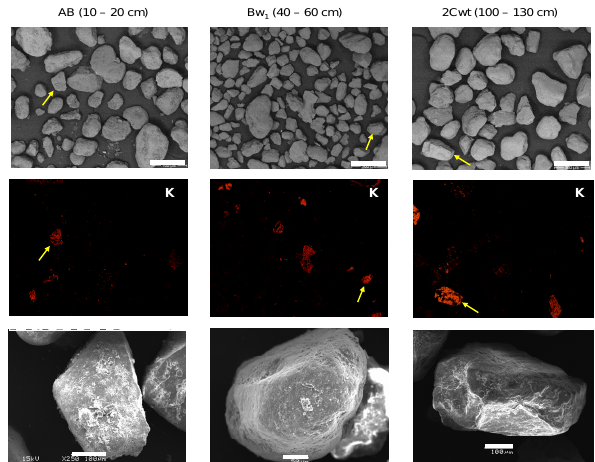
Fig. 6. SEM-micrographs and EDX element mapping (K) of soil material ( < 2mm) from three different depths; scale bars: upper row=700µm; lower row, left and right=100µm, middle=50µm; yellow arrows point to orthoclase mineral grains shown in lower